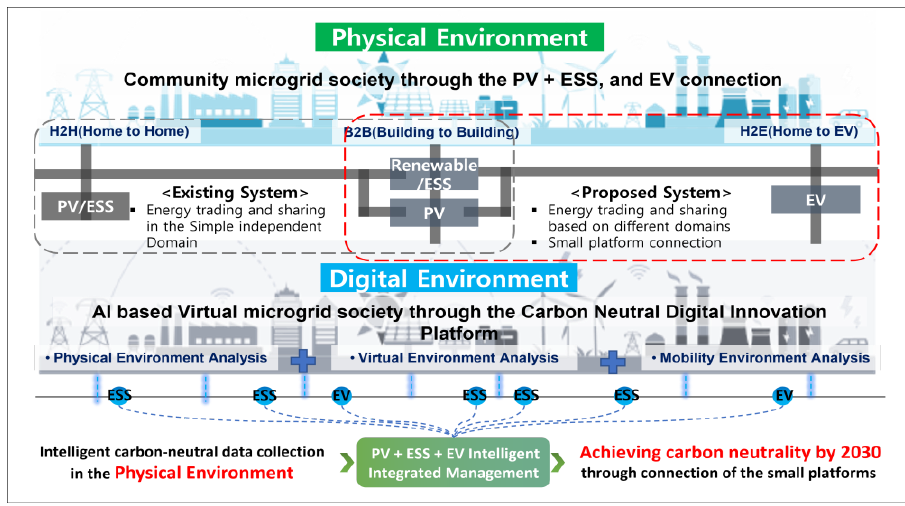
Figure 1. Concept of Proposed PV + ESS, and FEETS Connection System.